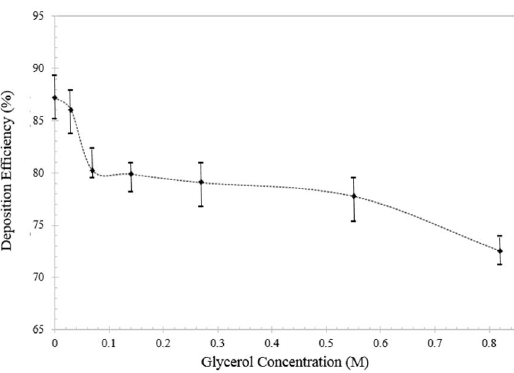
Figure 2. Effect of the presence of glycerol in the deposition bath (ZnCl 0.10M; KCl 2.8 M; H (CE) of the Zn galvanostatic deposition.